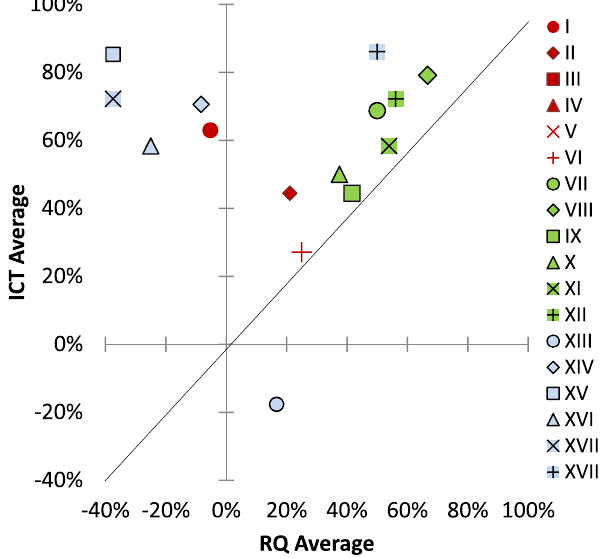
FIG. 5. Average scores on the comparison questions for the ICT vs the RQ. Error bars are not shown for clarity; the average standard error was (cid:2) 8 % for the RQ and (cid:2) 7 % for the